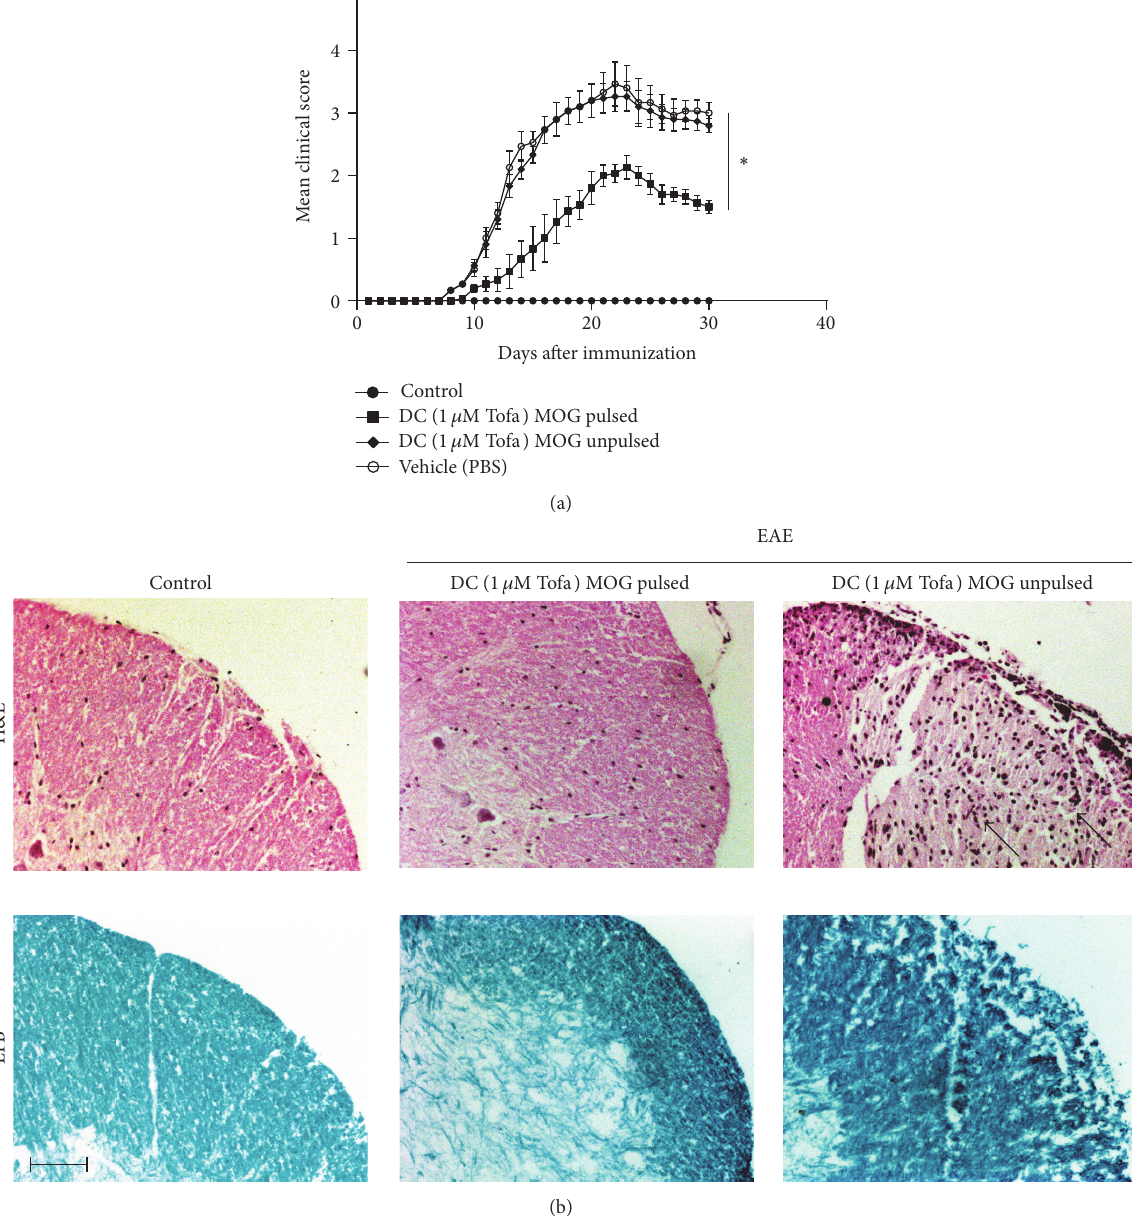
Figure 3: Tofa-treated DCs treatment ameliorated EAE. (a) C57BL/6 mice were immunized with MOG 35 peptide emulsified in CFA - 55 were injected intravenously into mice with EAE on days 7, 11, and containing M. tuberculosis . Tofa-treated DCs loaded or unloaded MOG 35 - 55 15 after immunization. EAE scores were determined daily after disease onset in the four groups with various treatment conditions. The mean EAE scores ± SEM are shown. The difference was significant at the onset of disease on day 11 and persisted until the chronic phase between group. ∗ 𝑃 < 0.05 by ANOVA/Tukey’s post hoc test. In addition, Tofa- the PBS group (vehicle) and Tofa-treated DCs pulsed with MOG 35 - 55 could not improve disease activity of EAE, similar to that of the PBS group. Results represent the average treated DCs unpulsed with MOG 35 - 55 disease score of eight mice per group. (b) H&E staining and Luxol Fast Blue staining of the paraffin sections of the spinal cords isolated from on day 23 after immunization. Arrows indicate EAE mice, which were injected with Tofa-treated DCs pulsed or unpulsed with MOG 35 - 55 inflammatory cell infiltration. Scale bar, 100 𝜇 m (magnification